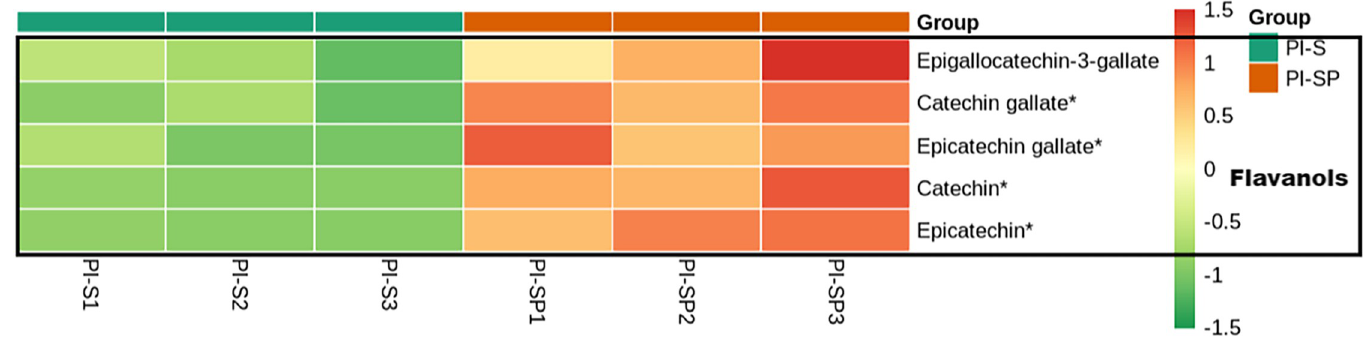
Fig 6. Heatmap of tea polyphenols in Pl-SP compare with Pl-S.